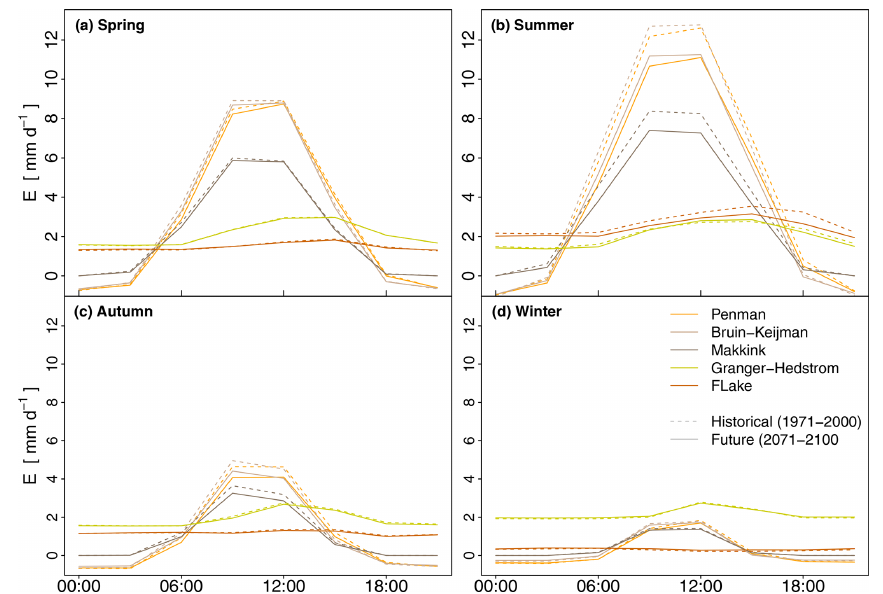
Figure 10. Projected seasonal change in the diurnal cycle of evaporation. Solid lines represent the historical period and the dotted lines the future